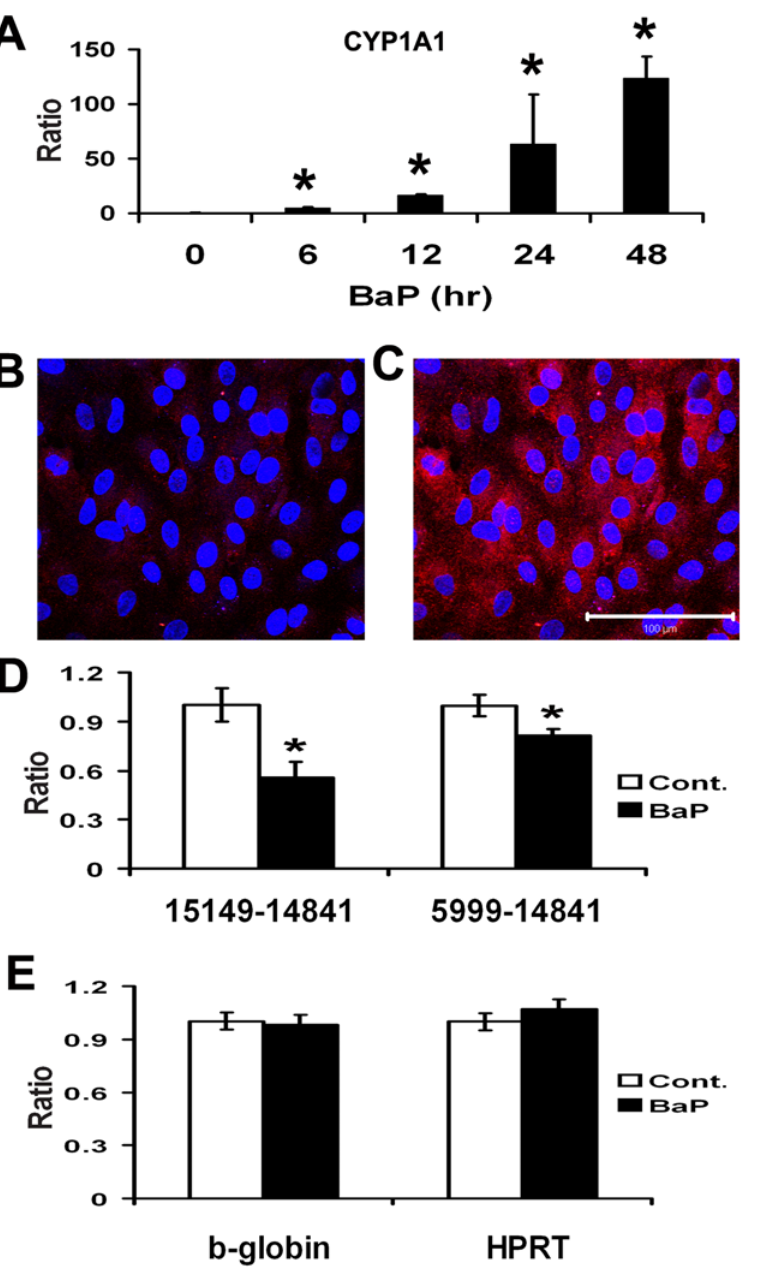
Figure 2. Damage to mtDNA by 10 m M B(a)P. ( A ) real time RT-PCR for CYP1A1. There is a significant increase of CYP1A1 expression levels after 6 hr B(a)P treatment and this increase continued with time at 12, 24 and 48 hrs. ( B–C ) BPDE-DNA adducts in ARPE-19 cells. In these confocal immunofluorescence images, an-anti-BPDE-DNA antibody labels particles in the cytoplasm of ARPE-19 cells after B(a)P treatment ( C ), but not in the control (B). (D–E) LX-PCR for mtDNA and nDNA. B(a)P at 10 m M damaged mtDNA (p , 0.05, n=3)., but not nDNA (p . 0.05, n=3). Data are expressed as normalized ratios (Control=1).